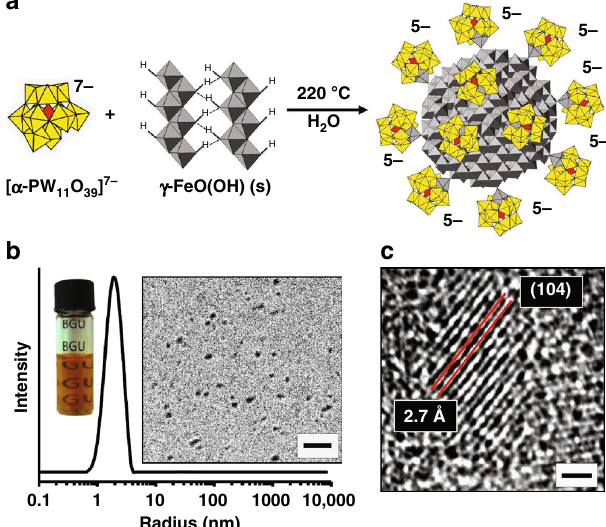
Fig. 1 Synthesis of the cluster-anion ligated hematite-core complex, 1 . a Synthesis of 1 by reaction of partially amorphous γ -FeO(OH) with α - PW 11 O 39 7 – at 220°C at pH 6.5 in water. An illustration of 1 is shown at the right; gray: Fe(III)-centered polyhedra; yellow: W(VI)-centered polyhedra; red: P(V)-centered tetrahedra. b Number-weighted dynamic light scattering of a clear-orange solution of 1 indicated particles with an average hydrodynamic radius of 1.9 nm. The left inset is a photograph of the clear- orange solution; the right inset is a cryo-TEM image of freely soluble particles of 1 in rapidly vitri fi ed water (scale bar: 10 nm). c HRTEM image of the hematite core of 1 with fringes corresponding to (104) planes (scale bar: 1